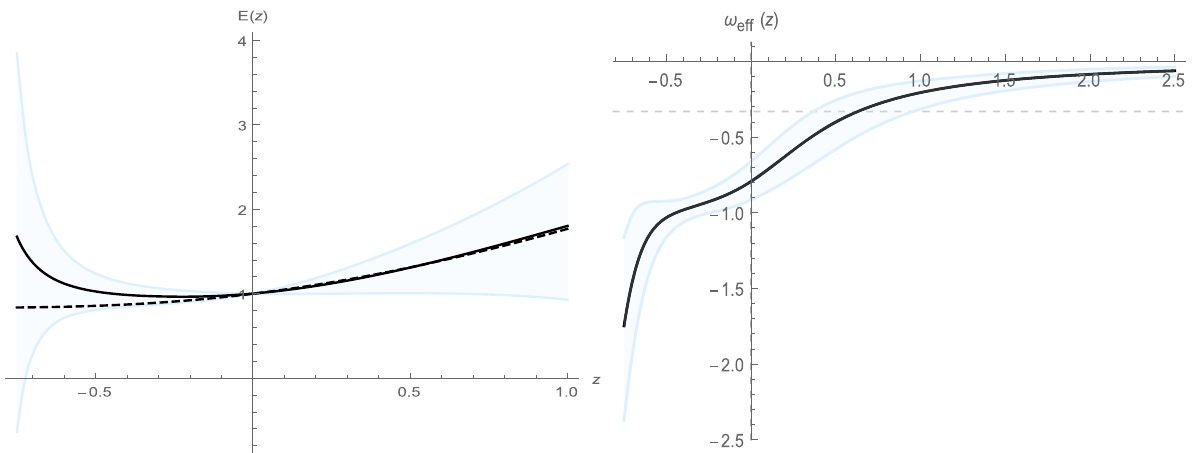
Fig. 2 The normalized Hubble parameter (left panel) and the effective parameter state (right panel). The black solid line in each case corre- sponds to the best fit values for the parameters of the model and the